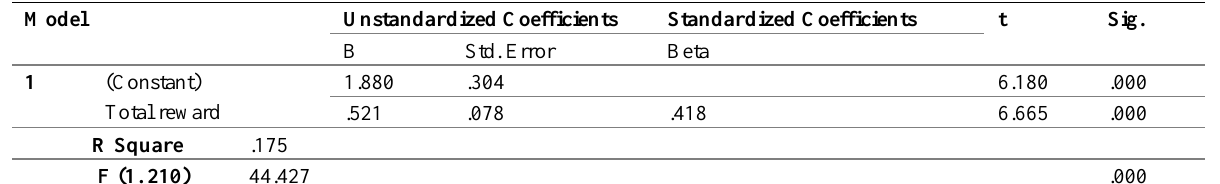
Table 2: Linear regression on total rewards and workspace